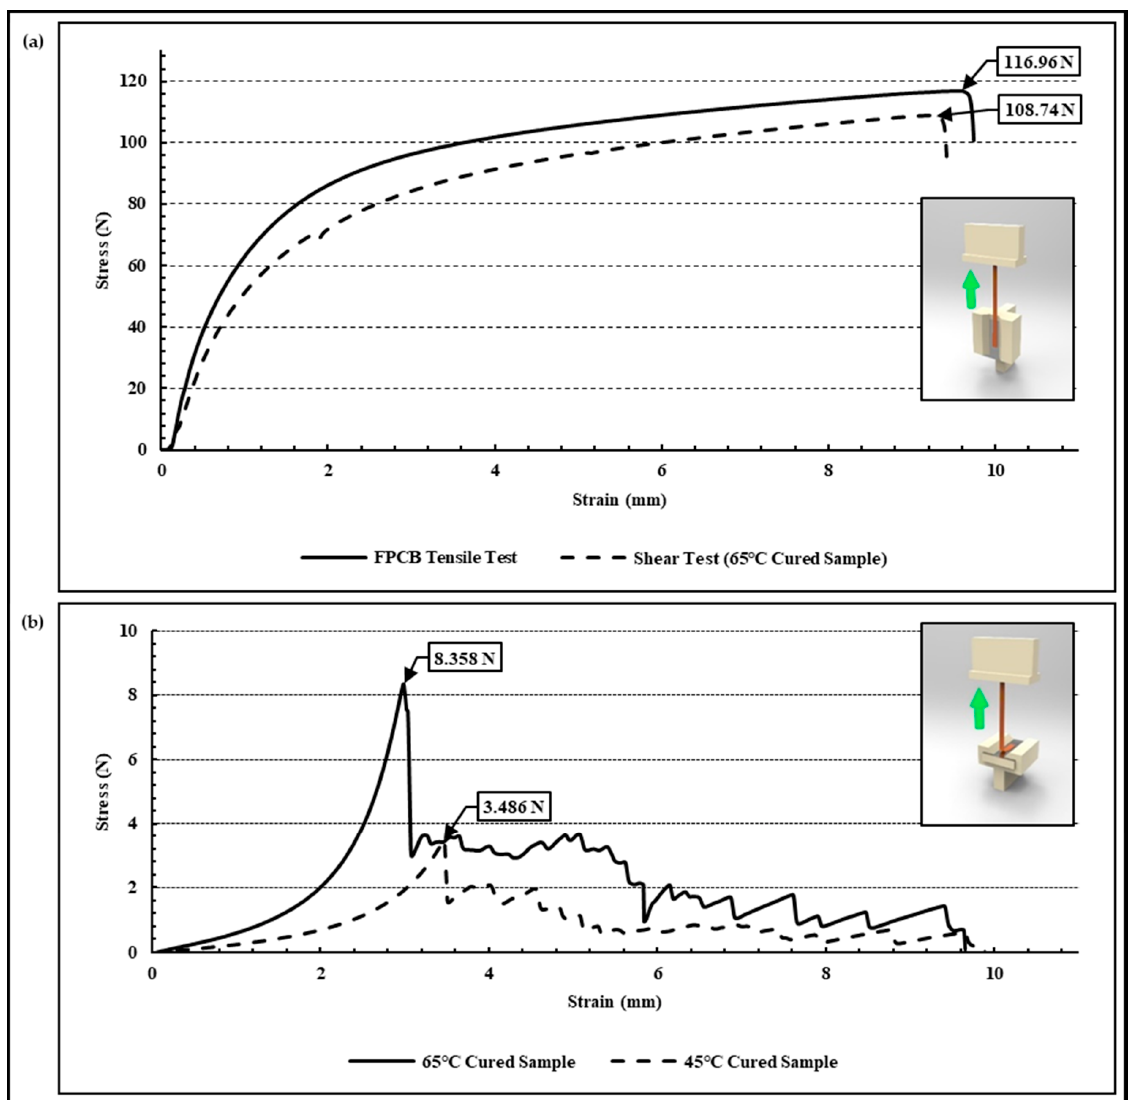
Figure 6. Results of Adhesion test. ( a ) Shear-force induced samples and ( b ) tear-force induced sam-